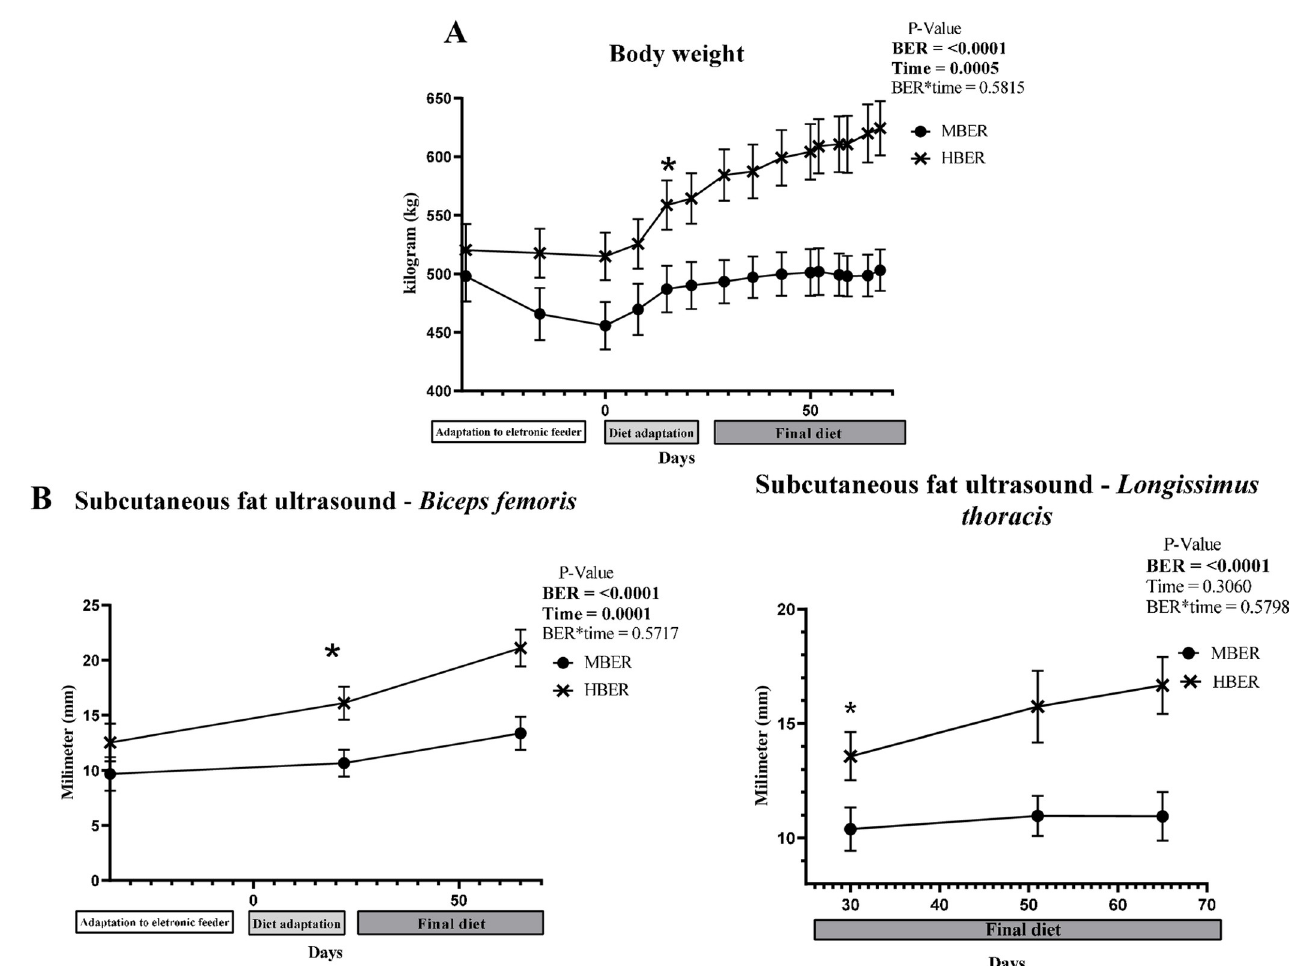
Fig 2. Body weight and subcutaneous fat ultrasound of Nellore cows during the experimental period. A. Evolution of body weight of cows with different energy reserves. B. Analysis of subcutaneous fat thickness of Biceps femoris and Longissimus thoracis measured by carcass ultrasound of cows with different energy reserves. Mean standard error for body energy reserve, time and body energy reserve and time interaction. P-values are on the right top of the Figs. � Beginning and prevalence of statistical differences ( P < 0.05).